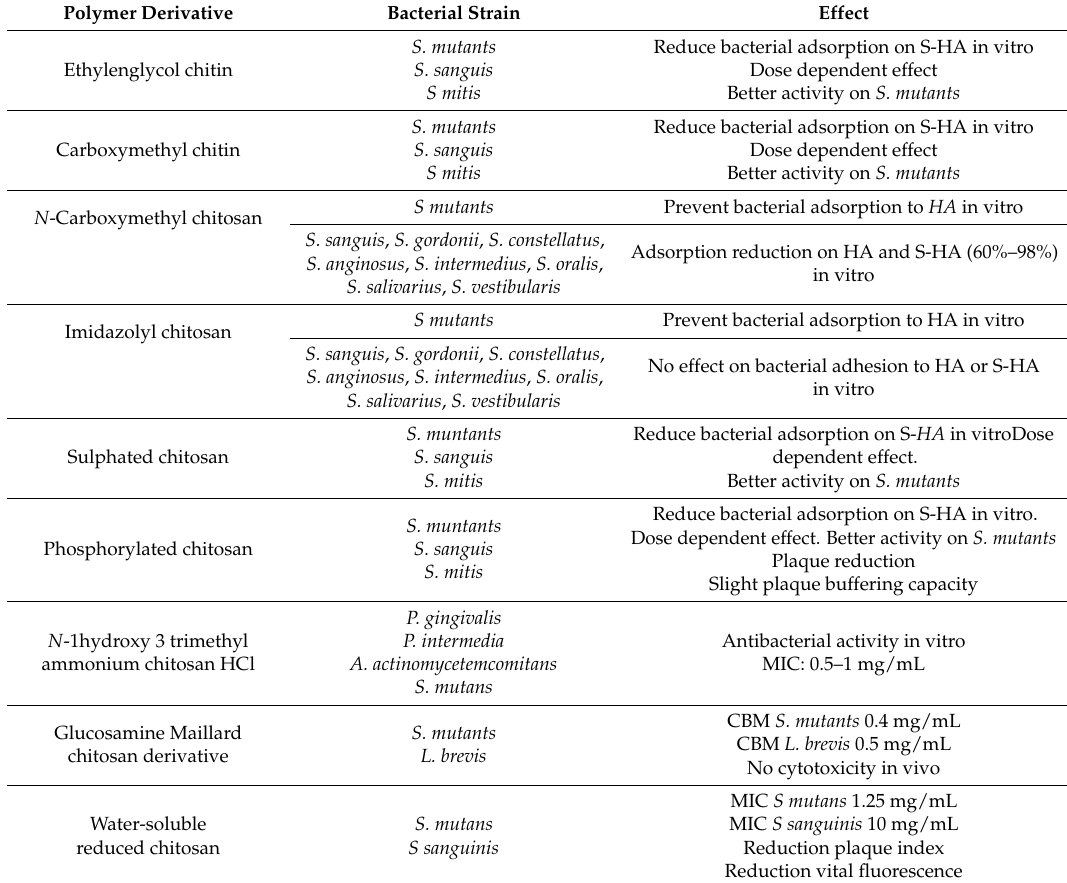
Table 6. Use of chitin and chitosan derivatives in oral healthcare